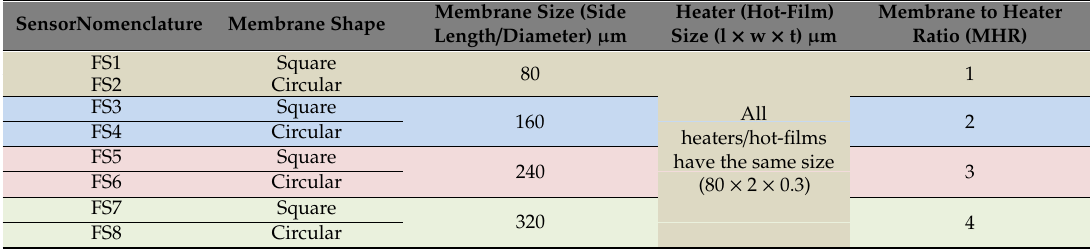
Table 6. Geometric Parameters of the Fabricated SOI CMOS MEMS Thermal Hot-Film Sensors. SensorNomenclature Membrane